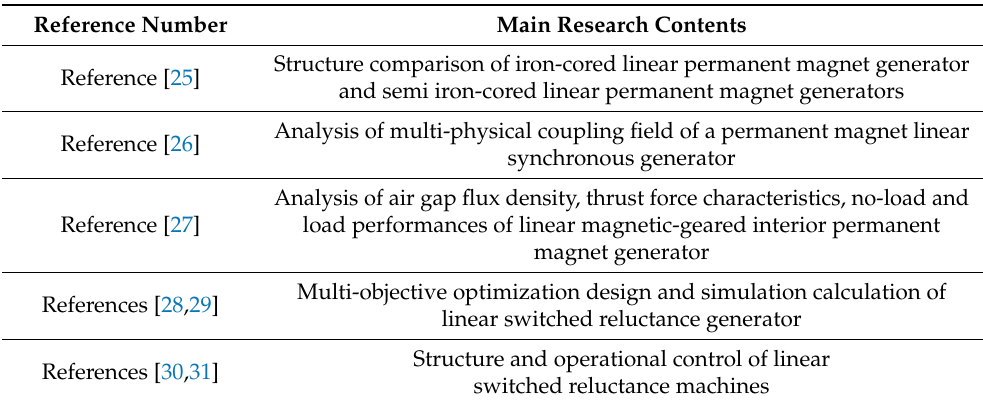
Table 1. Optimization of linear generator for ocean wave power generation